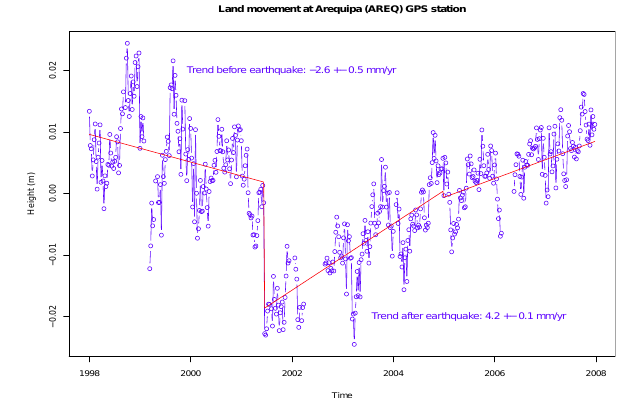
Fig. 12. The height trend change at GPS station Arequipa (AREQ) from − 2.6 ± 0.5mmyr − 1 to + 4.2 ± 0.1mmyr − 1 caused by the 2001 Arequipa–Camana–Tacna area